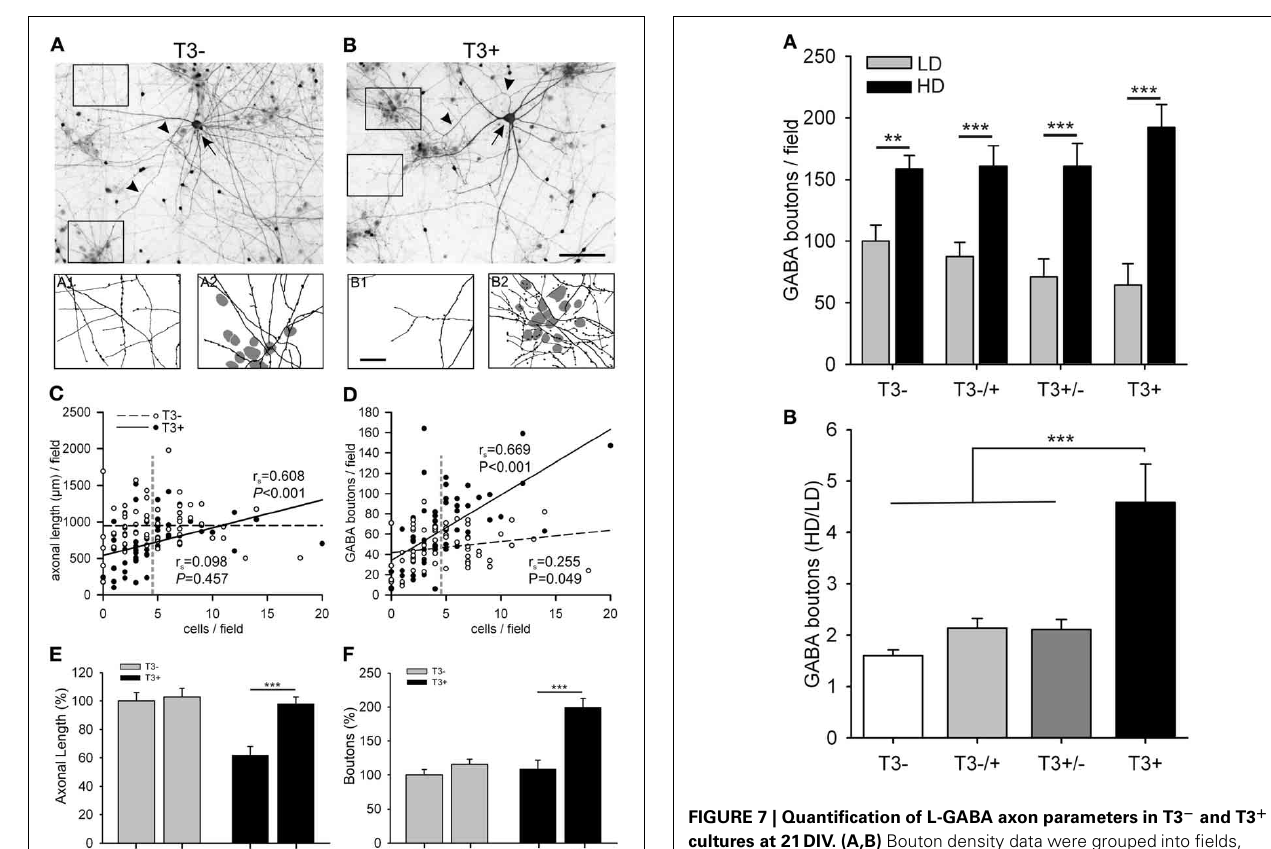
significantly the mean number of active neurons or the maxi- mal burst attendance registered in each field (Two-Way-ANOVA, P = 0 . 082 and P = 0 . 046, respectively).